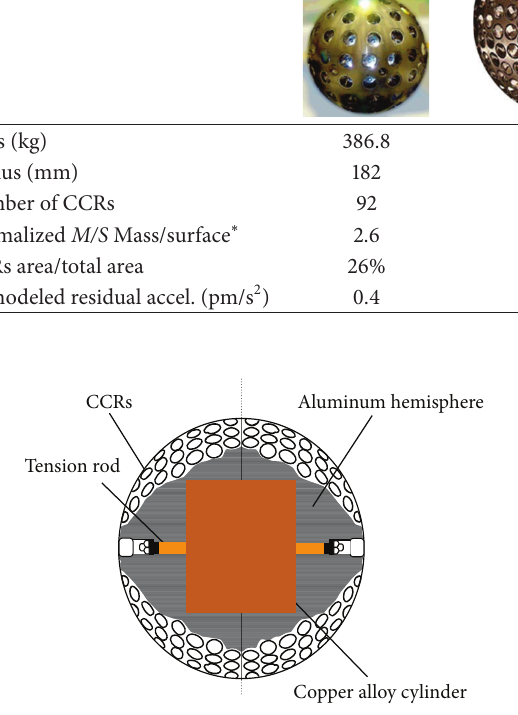
Figure 2: LAGEOS satellite main